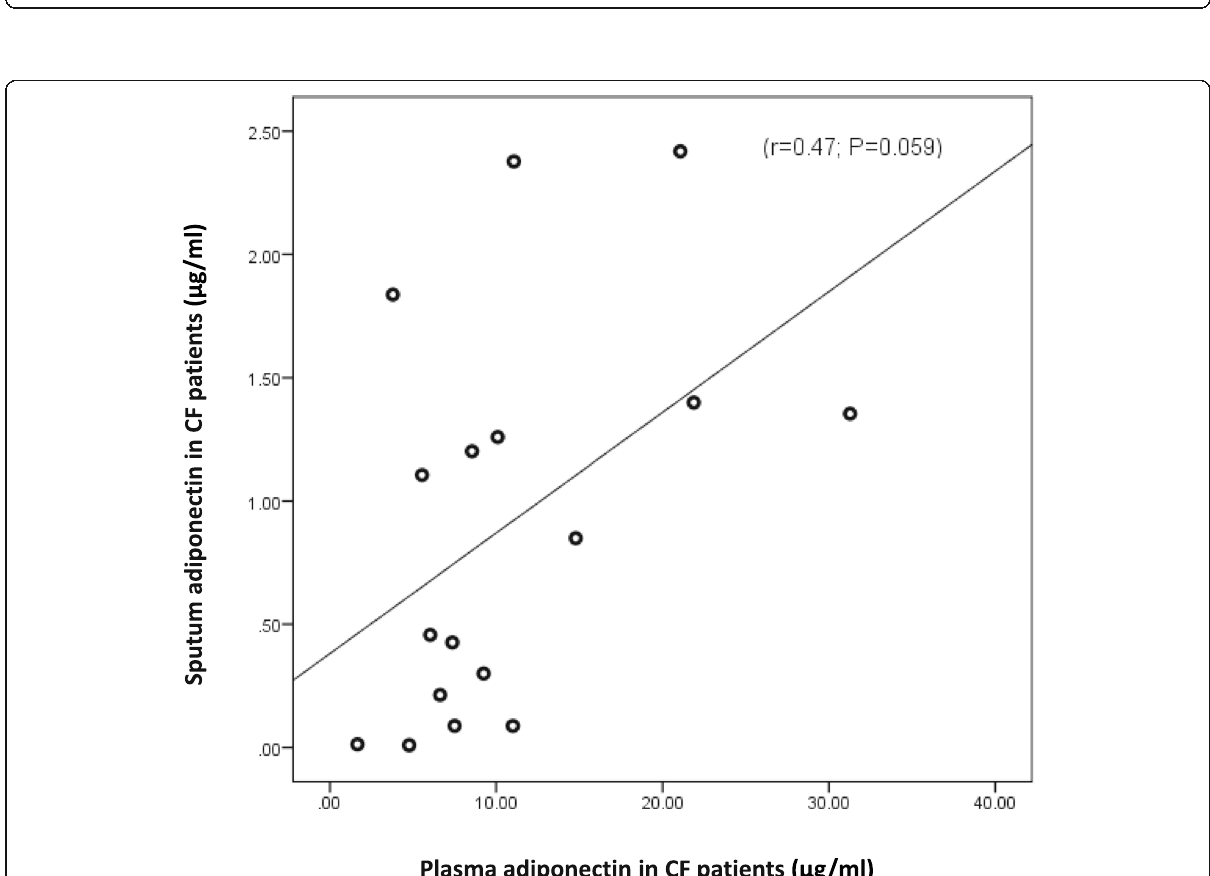
Fig. 2 Correlation between sputum adiponectin level and plasma adiponectin level in CF